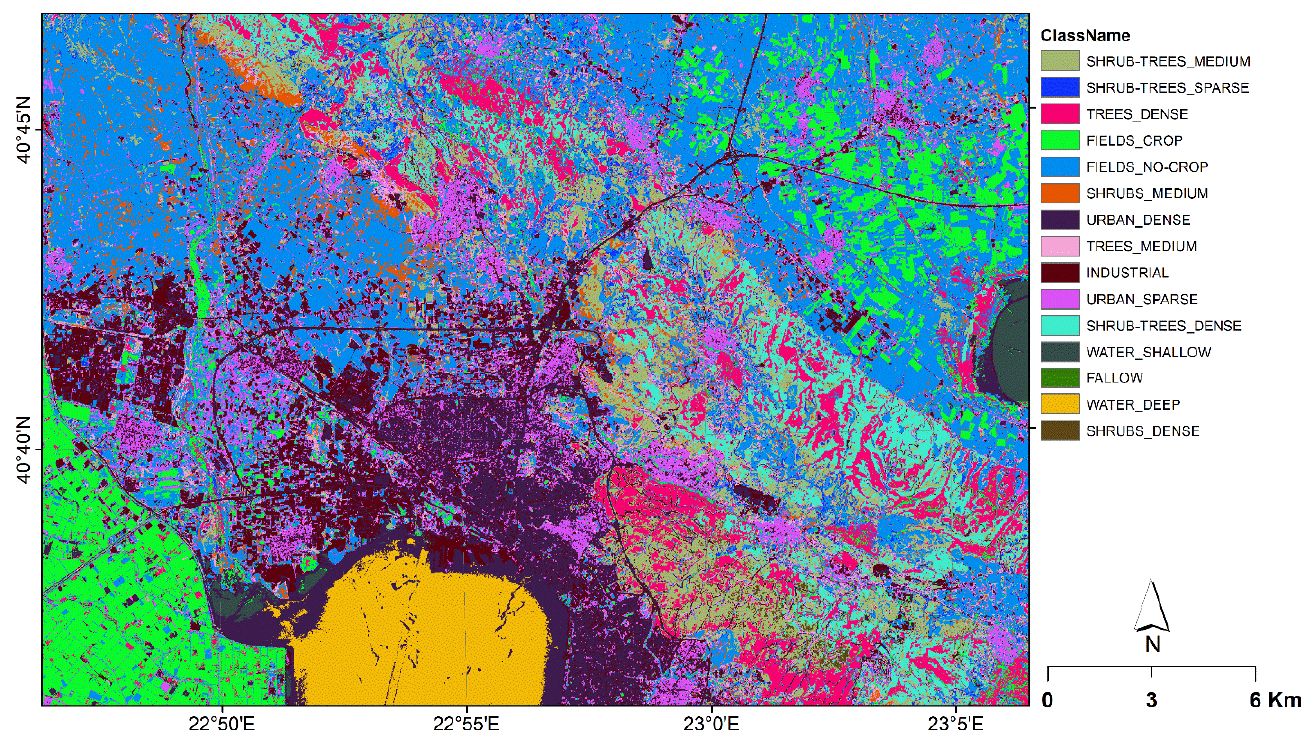
Figure 5. The classified image resulting from the 75-scale segmentation.